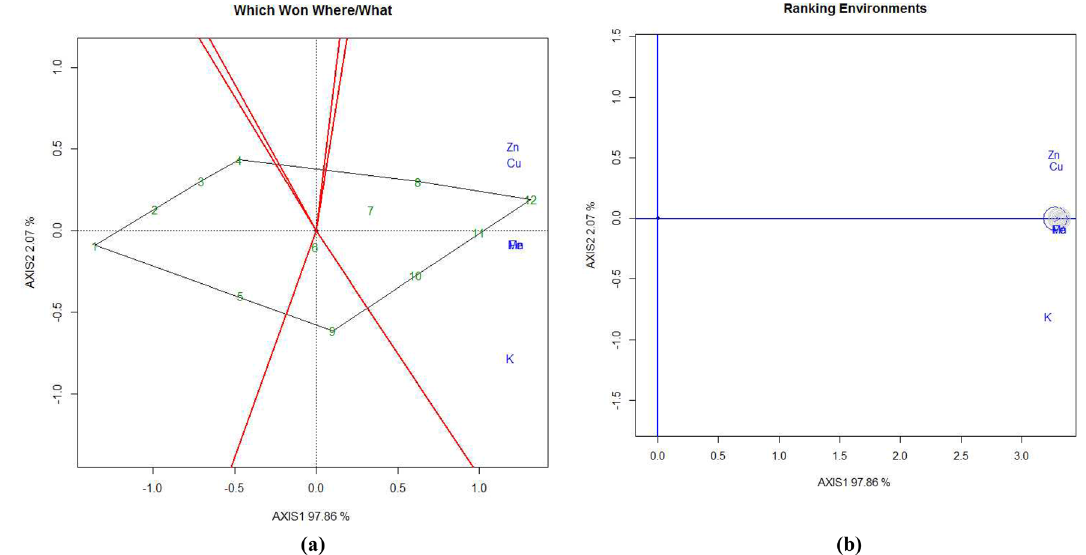
Figure 5. GGE biplot analysis of nutrient accumulation in eggplant shoot under experimental treatments. ( a ) Polygon view (which won where/what), ( b ) ranking environments. AXIS 1 Principal Component 1, AXIS 2 principal component 2. #1 = RDF1-MNENPK1; 2 = RDF1-MNENPK2; 3 = RDF1-MNENPK3; 4 = RDF1- MNENPK4; 5 = RDF2-MNENPK1; 6 = RDF2-MNENPK2; 7 = RDF2-MNENPK3; 8 = RDF2-MNENPK4;